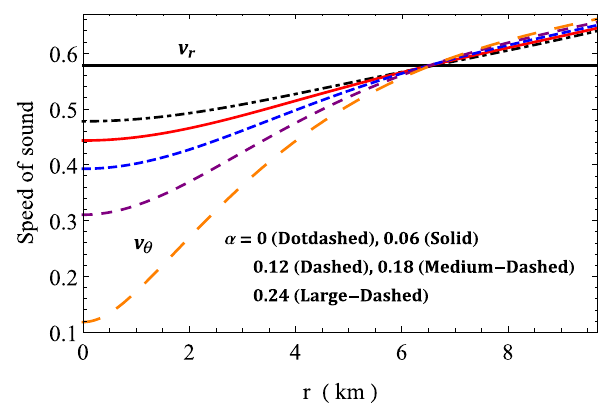
Fig. 3 Variation pressure with r for M = 1 . 97 M (cid:3) , R = 9 . 69 km , b = 0 . 000015 / km 4